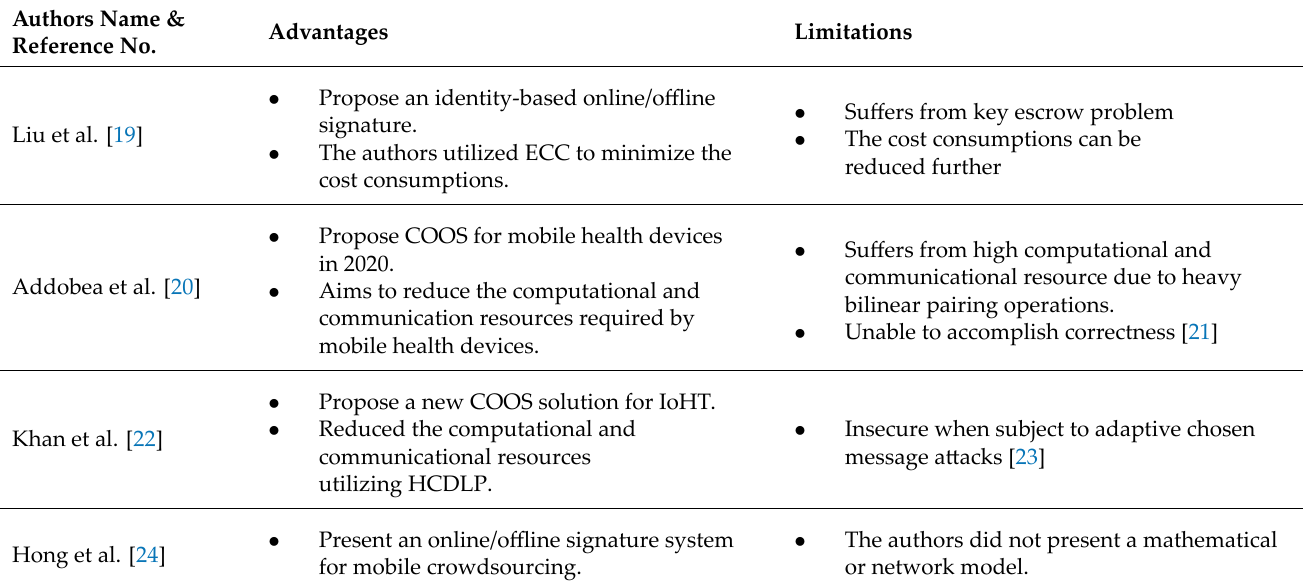
Table 1. Summary of the